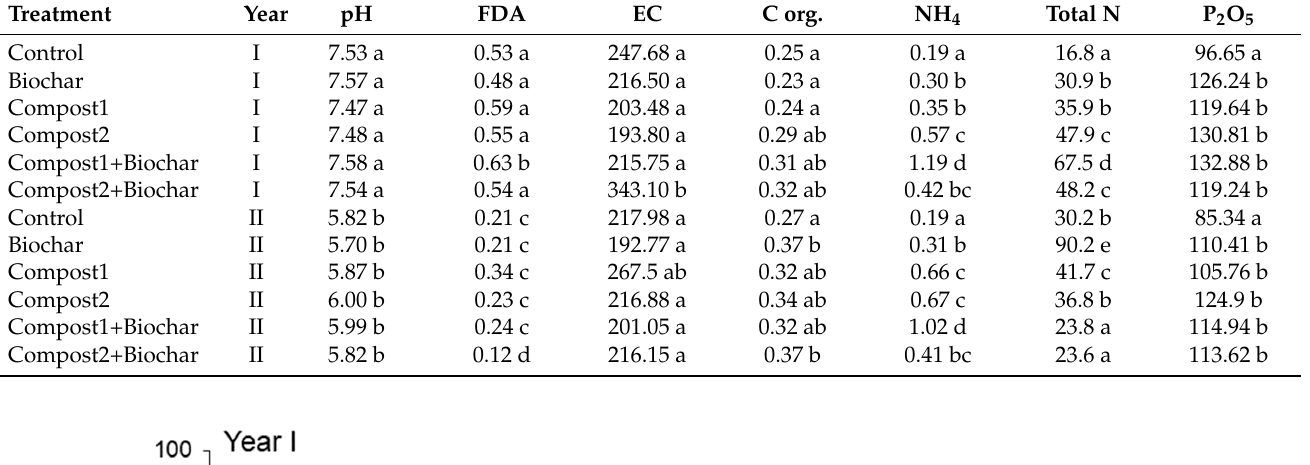
Table 3. Soil chemical parameters after one and two years of organic amendment application. Different letters within each column indicate significantly different groups (Duncan test, p < 0.05).